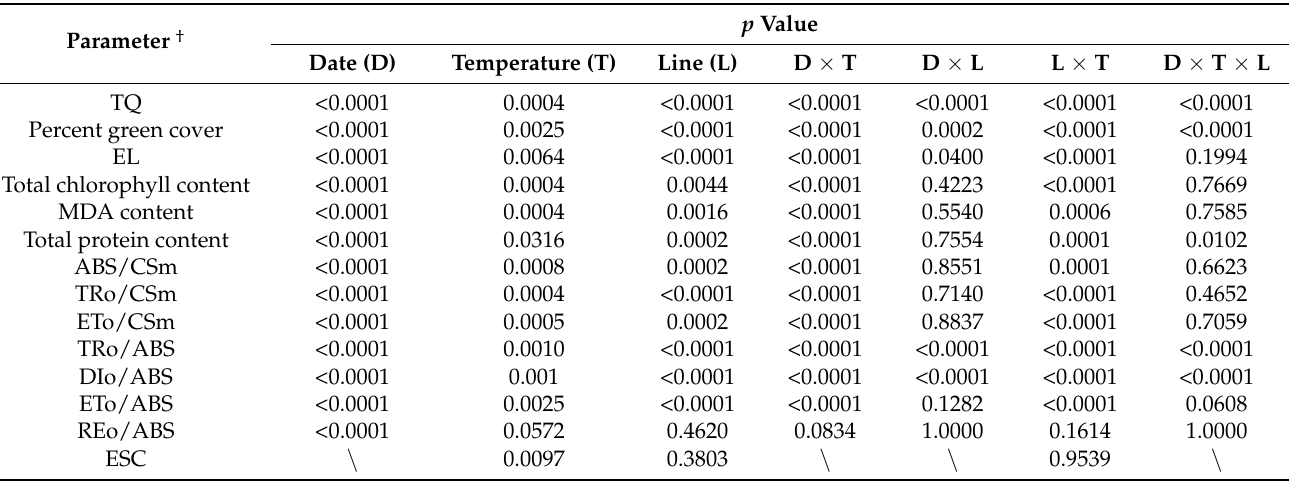
Table 1. ANOVA results for heat stress trials of creeping